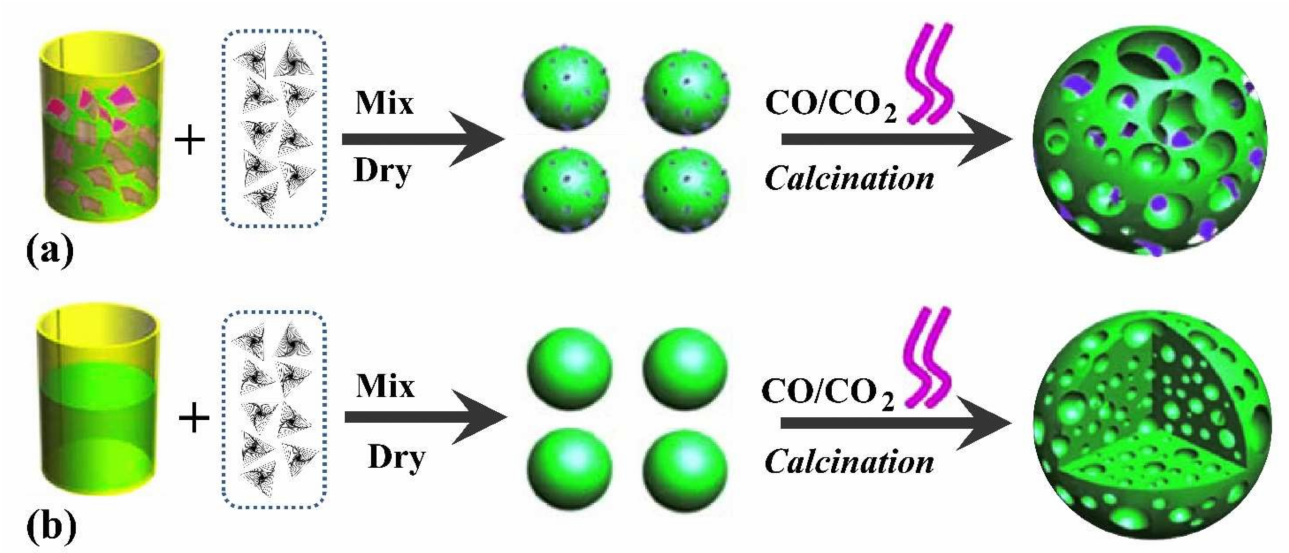
Figure 26. Schematic representation of the formation of 3D porous networks ( a ) LFP/graphene and ( b ) LFP. Adapted and reproduced with permission from Ref. [110]. Copyright 2012